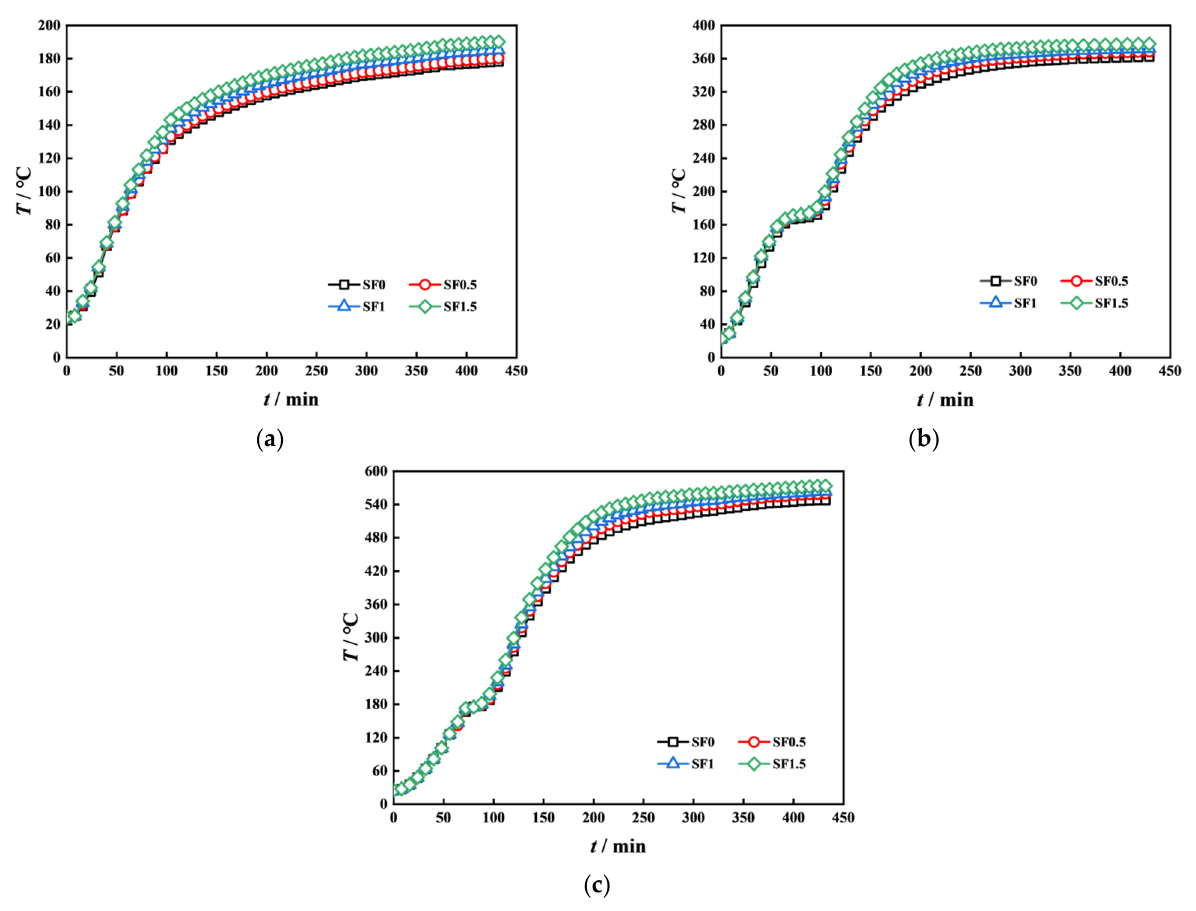
Figure 6. Temperature–time curve of the bone zone between rebar and SFRC at ( a ) 200 °C, ( b ) 400 °C, and ( c ) 600 °C.